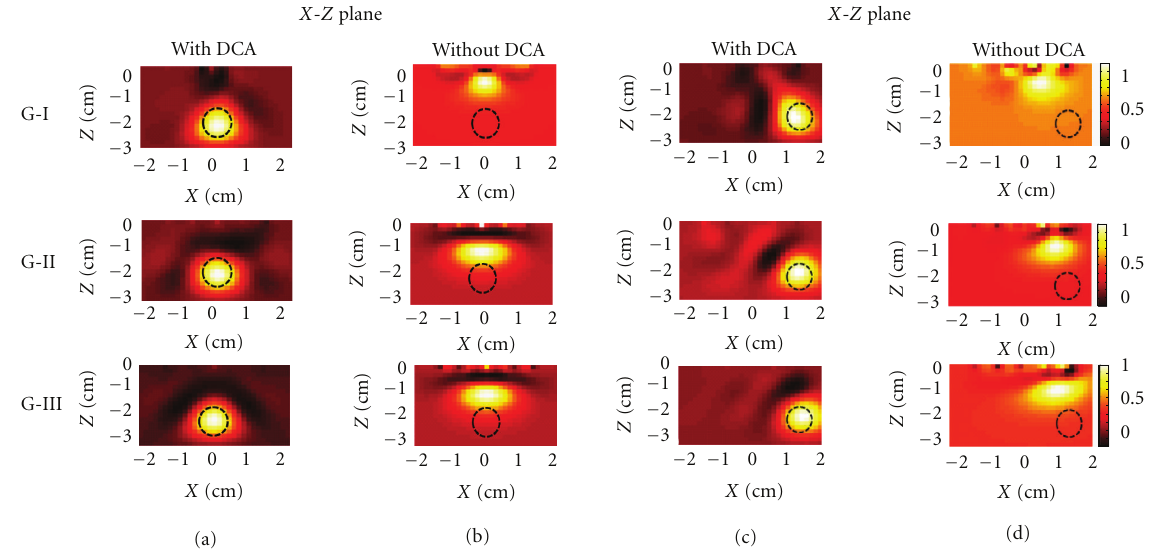
Figure 7: Reconstructed DOT images of a single object in X - Z plane: (a) and (c) with DCA ( γ = 1 . 3), and (b) and (d) without DCA. Top-to-bottom rows were obtained from G-I to G-III (Figure 5).